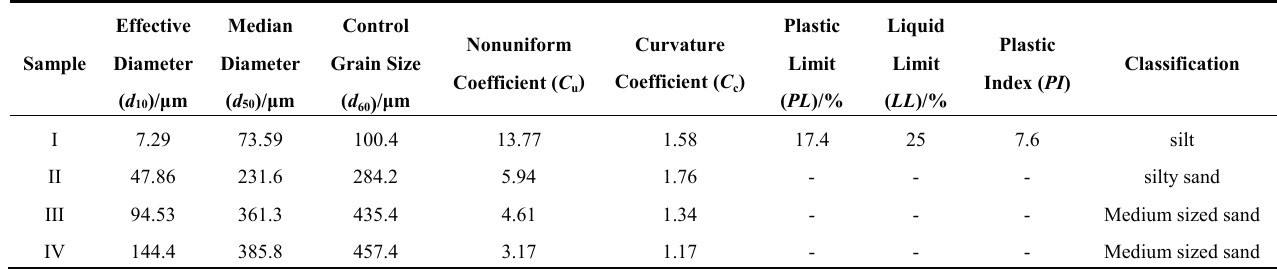
Table 2. PSD parameters and main physical indexes of the tailings.